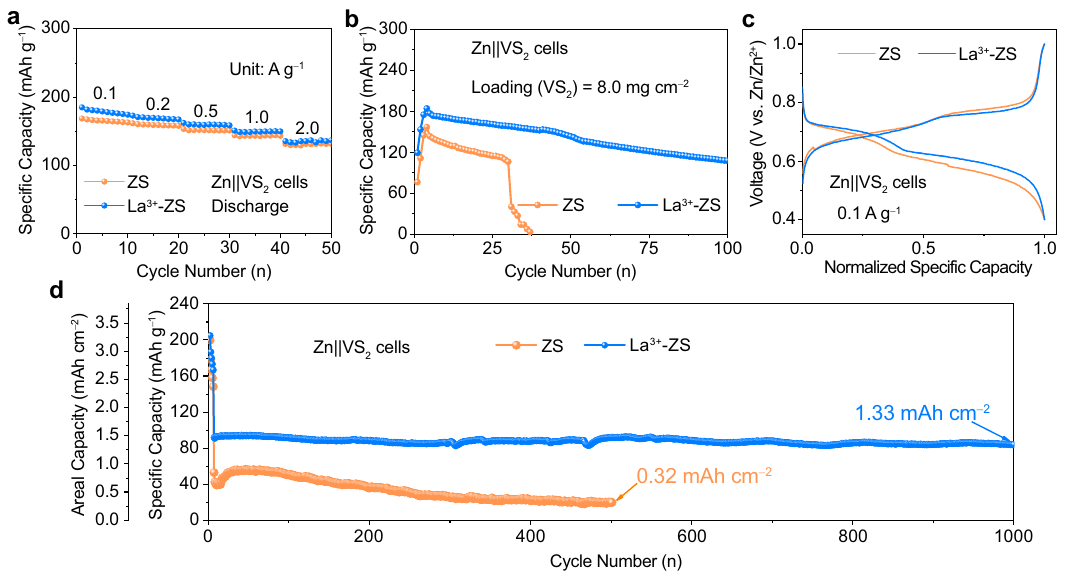
Fig. 5 The electrochemical performance of Zn||VS 2 cells in ZS and La 3 + -ZS electrolytes. a The rate performance. b The cycling performance with a limited Zn supply (N/P capacity ratio: 4.3). c Normalized charge-discharge curves of ( b ) at the 20 th cycle. d The cycling performance with a limited Zn supply (11.6 mAh cm − 2 ) and a high-loading VS 2 cathode (16.0 mg cm − 2 ) at a current density of 16.0 mA cm − 2